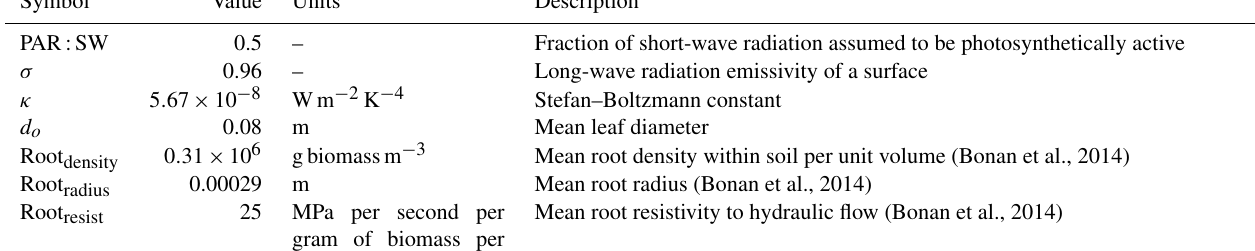
Table 3. Parameters describing physical or biophysical constants not retrieved as part of the CARDAMOM model–data fusion analysis. Symbol Value Units